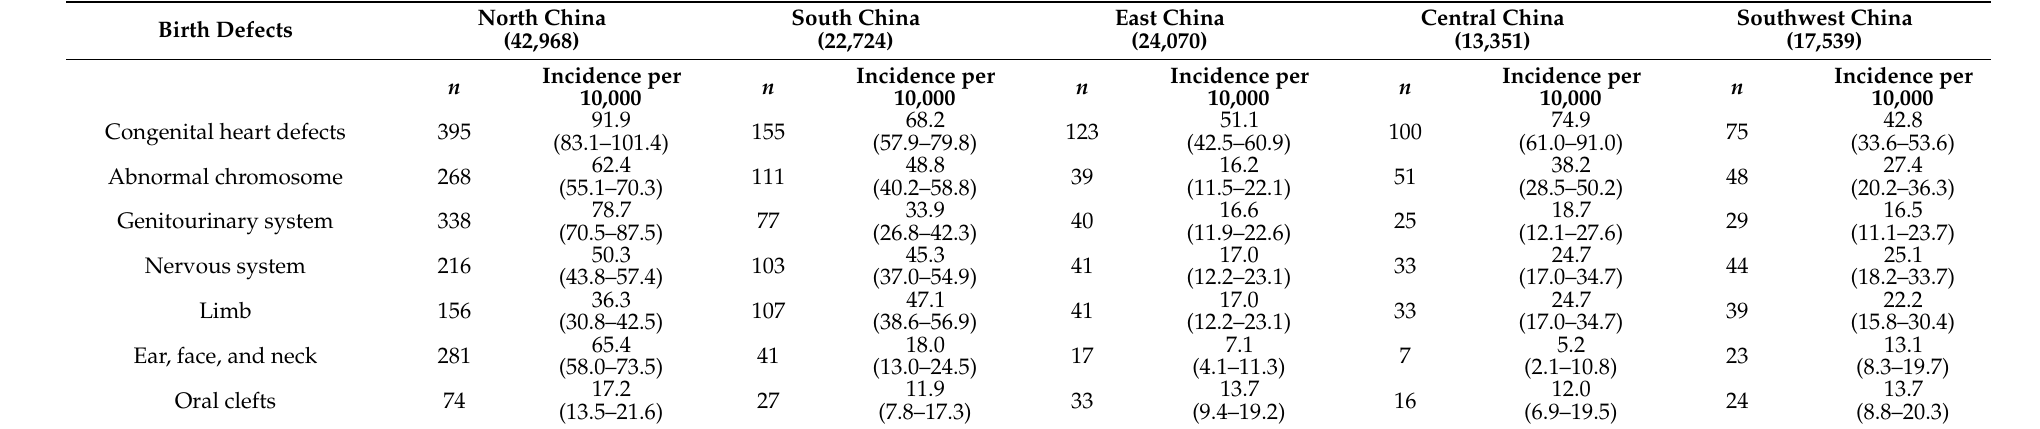
Table 3. Incidence and its 95% confidence interval of major birth defects across different regions in